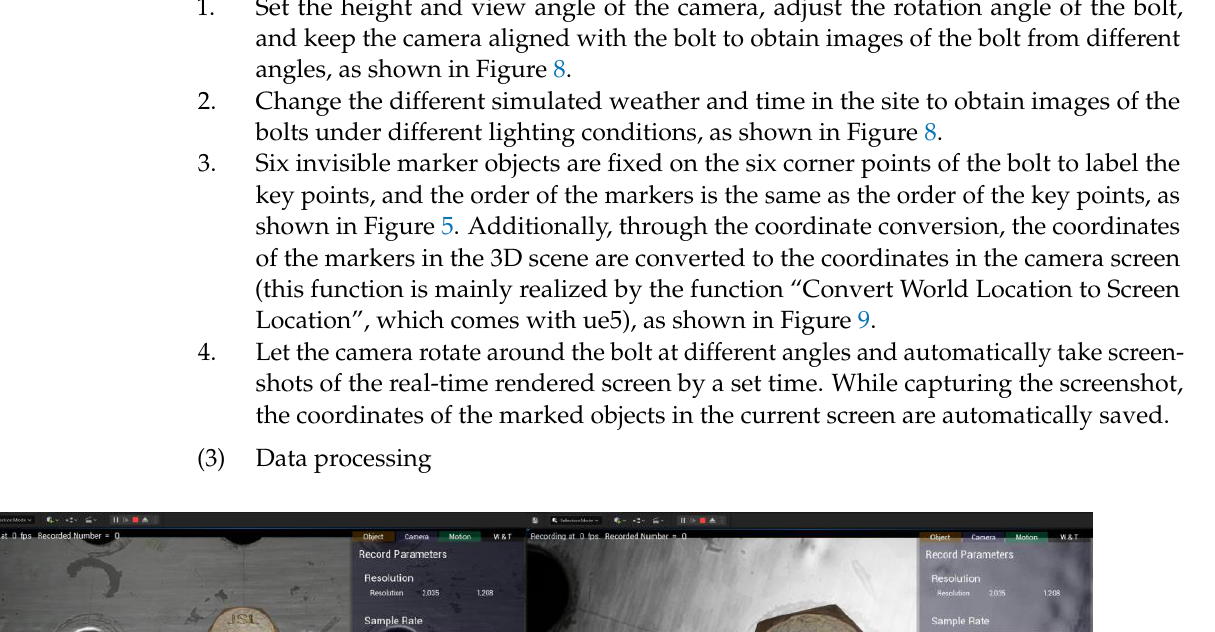
Figure 9. Marker objects fixed on the bolt model. Figure 10. The result of key-point labeling and recognition box generation. 2.3. Training We obtained trained datasets in different volumes based on YOLOv7-pose: the latest key-point detection technology.